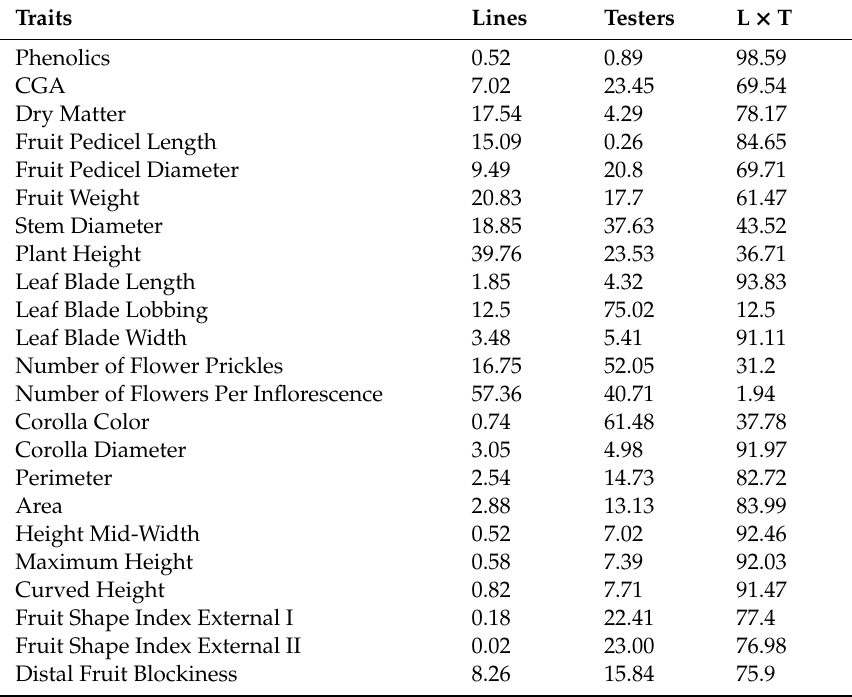
Table 4. Contribution of lines, testers, and their cross (L × T) in the expression of characters studies.